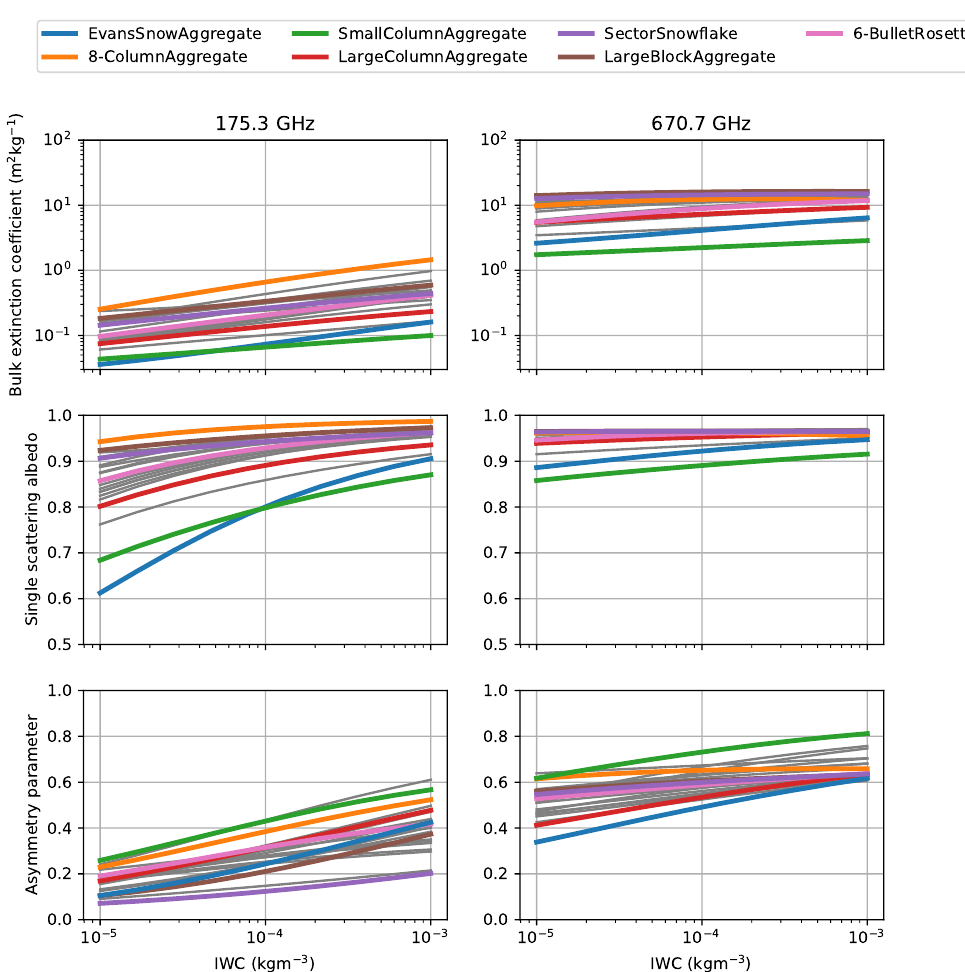
Figure 3. Bulk optical properties for ARTS database ice particle habits considered for cloud ice hydrometeors, calculated using the F07 tropical size distribution at a temperature of 230 K. The coloured lines indicate the habits selected for this study, and the grey lines represent the remaining cloud ice